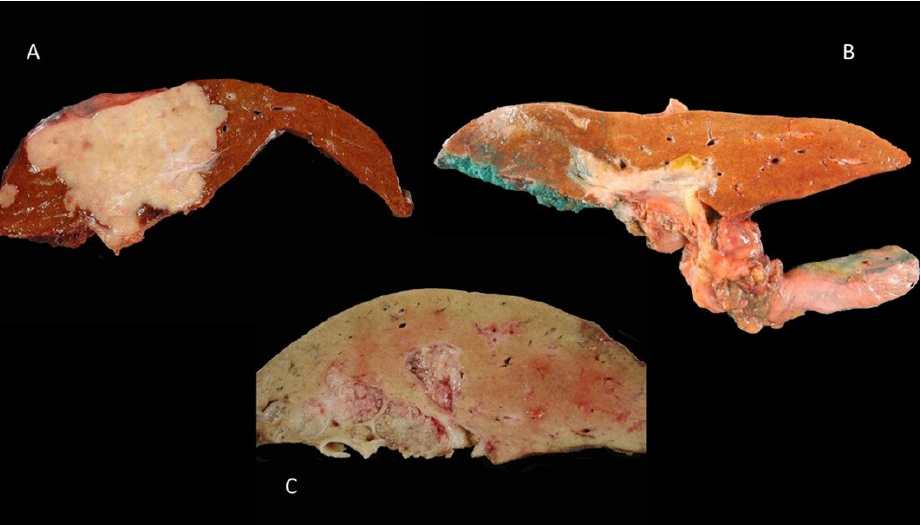
Figure 2. Macroscopic classification of cholangiocarcinoma: ( A ) mass-forming type of an intrahepatic cholangiocarcinoma, ( B ) periductal infiltrating of perihilar cholangiocarcinoma and ( C ) intraductal growth of left biliary duct.